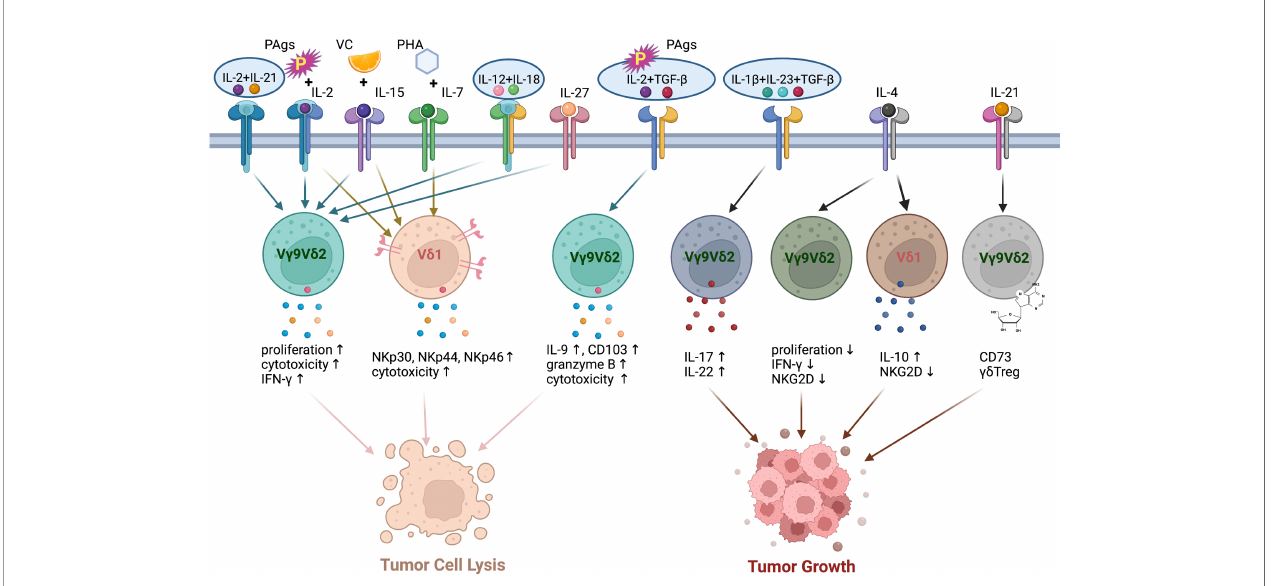
FIGURE 3 | The polarization of human gd T cells induced by different cytokine combination. PAgs and IL-2 with the addition of VC and IL-15, IL-12+IL-18, IL-27, IL- 21+IL-2 enhance the cytotoxicity of human V g 9V d 2 T cells. IL-2 or IL-15 induces the expressions of NKp30, NKp44, NKp46 on human V d 1 cells. PHA and IL-7 enhance the cytotoxic capacity of human V d 1 cells. TGF- b increases the anti-tumor cytotoxicity of human V g 9V d 2 T cells in the presence of PAgs and IL-2. The combination of IL-1 b , IL-23 and TGF- b promotes the differentiation of V g 9V d 2 T cells to IL-17-producing gd T cells. IL-4 reduces the proliferation, NKG2D expression and IFN- g production of V g 9V d 2 T cells via promoting IL-10 secretion of V d 1 cells. IL-21 alone induces V g 9V d 2 T cell differentiation to CD73 + gd Treg cells, which promote tumor